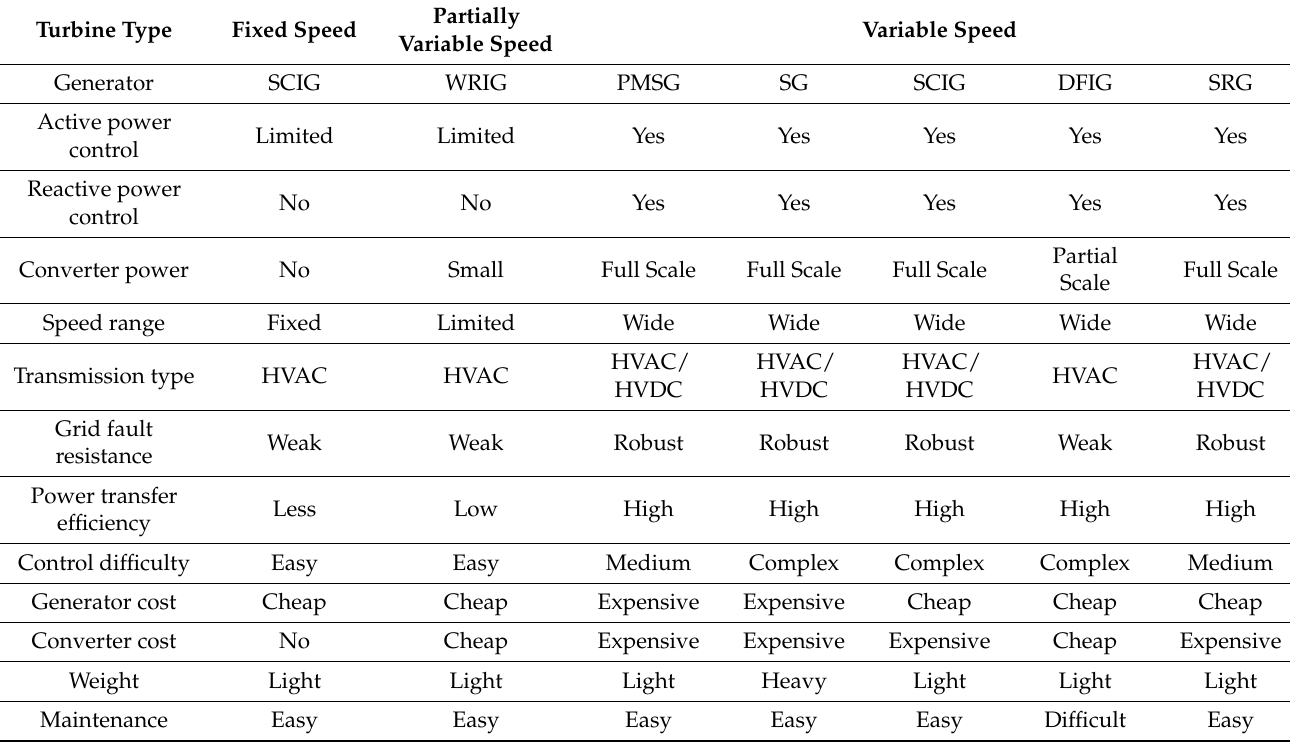
Table 1. Wind Turbine System Comparison